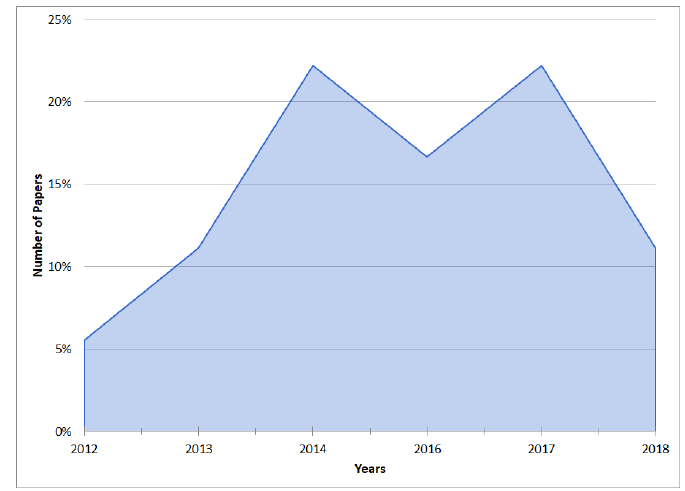
Figure 6. Ultrasonic sensor